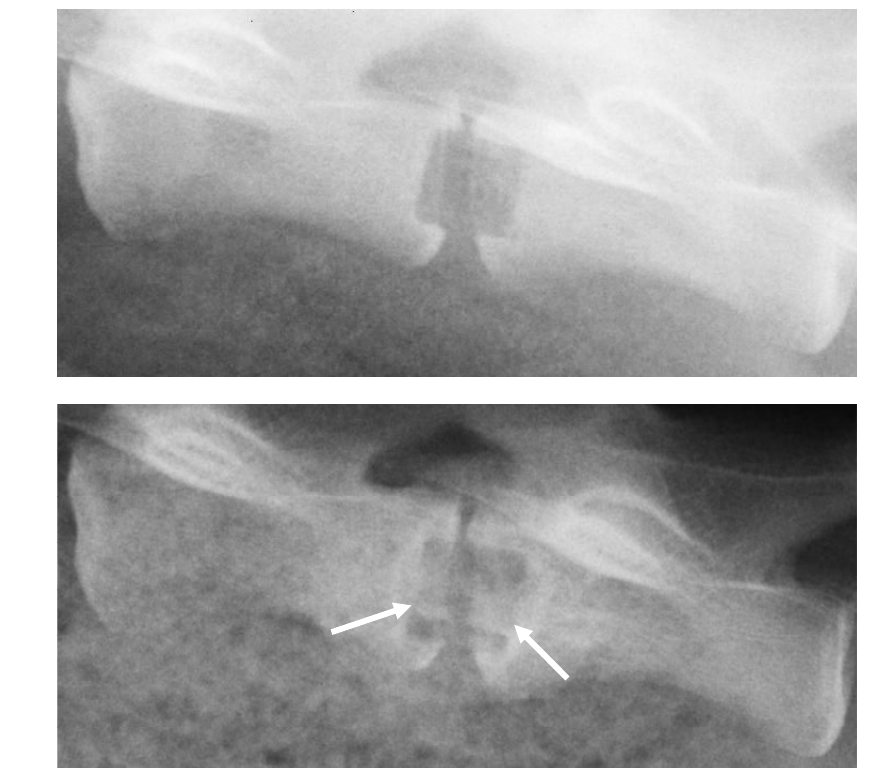
Figure 4. Lateral roentgenogram of a goat, using both a radiolucent cage and polymer cage filler (a) directly postoperative and (b) prior to sacrifice, 6 months after surgery, in which bone formation in the cage, indicated by the white arrows, can be